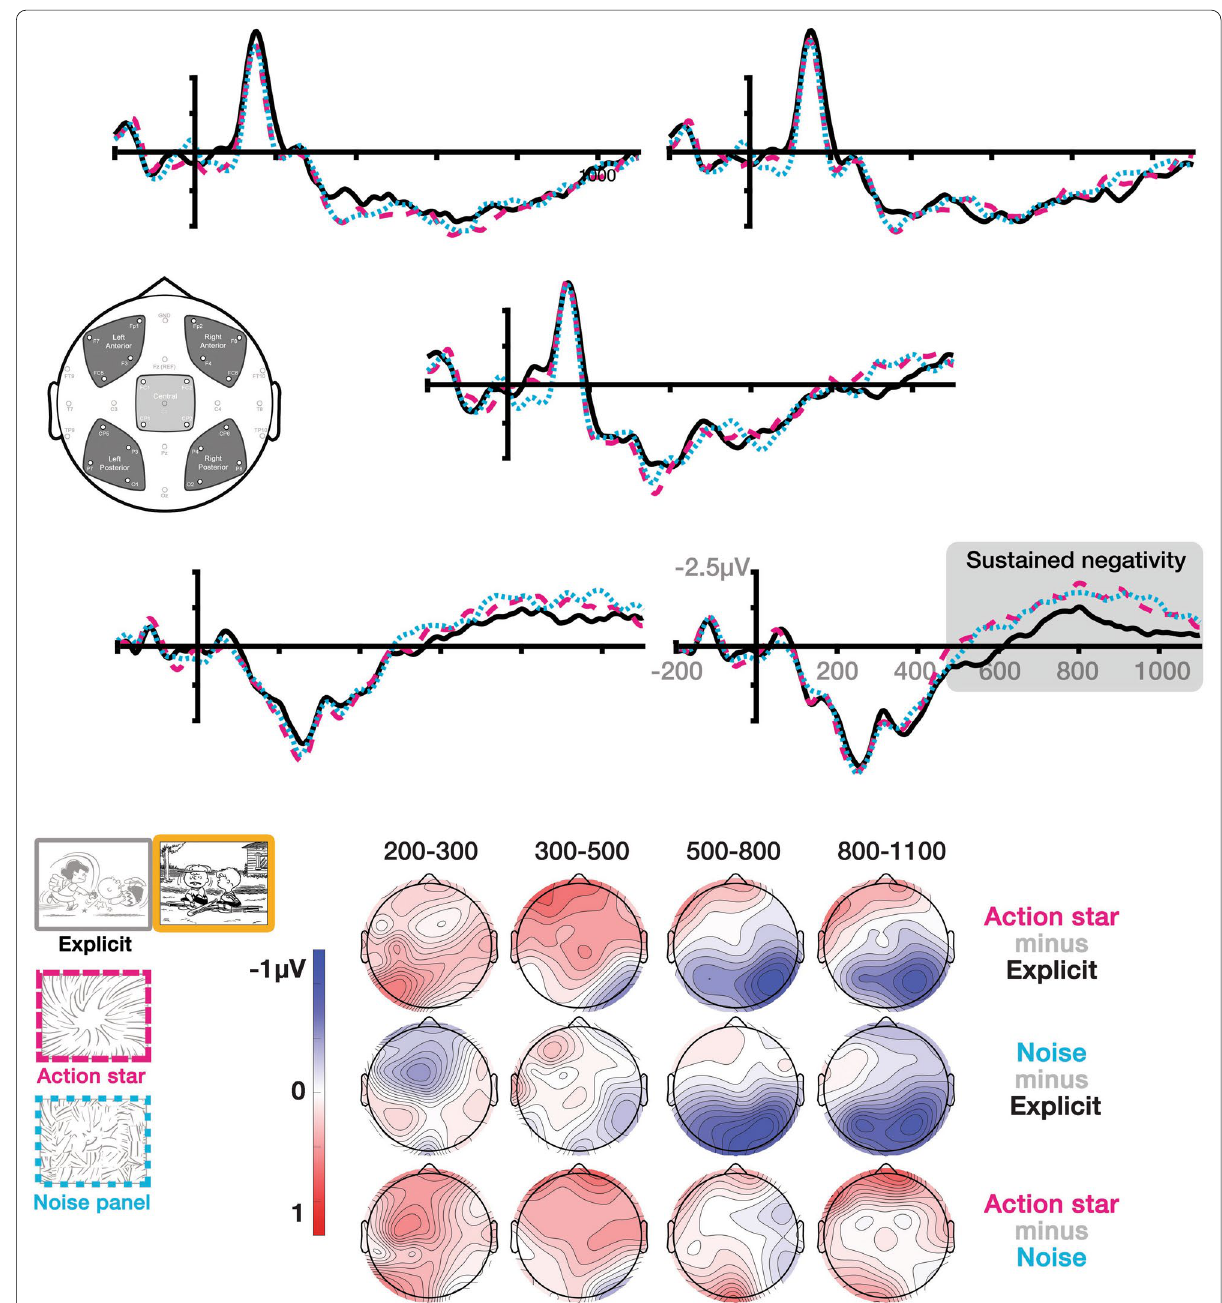
Fig. 4 ERPs time-locked to the critical panel 1, i.e., the panel following explicit event panels, action stars, and noise panels represented across + individual electrodes and topographic maps. Highlight shows the analyzed epoch of the sustained negativity. Positivity Negative is plotted